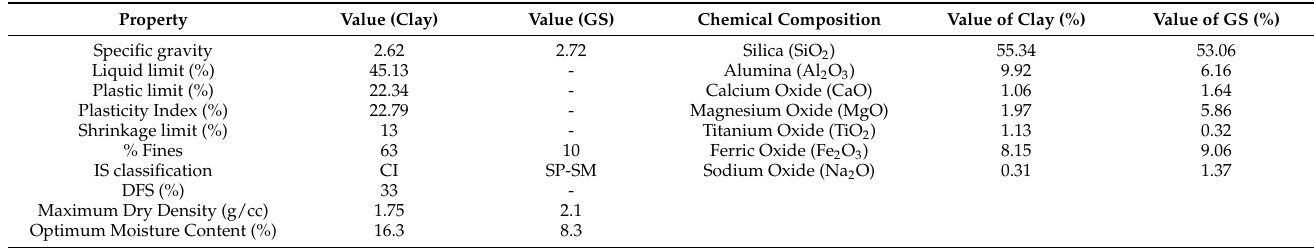
Table 1. Index properties and Chemical composition of Clay and GS.